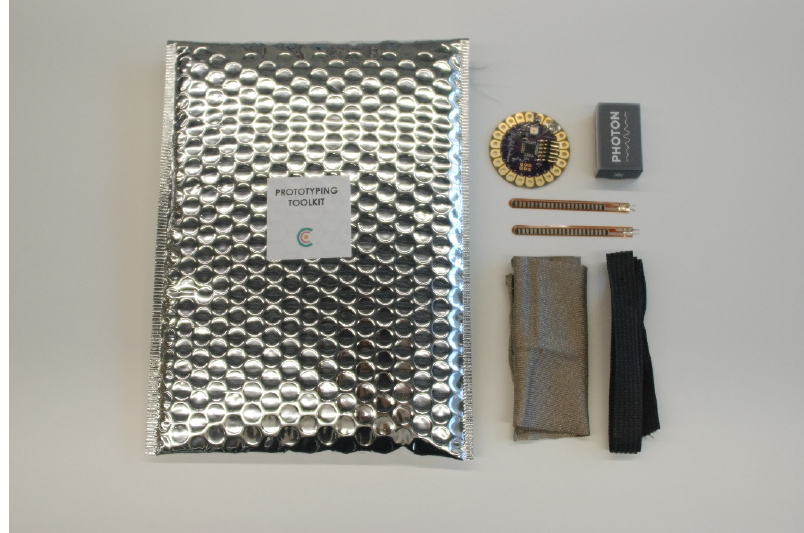
Figure 8. Prototyping Toolkit included in the Wearable Co-Design Domino.